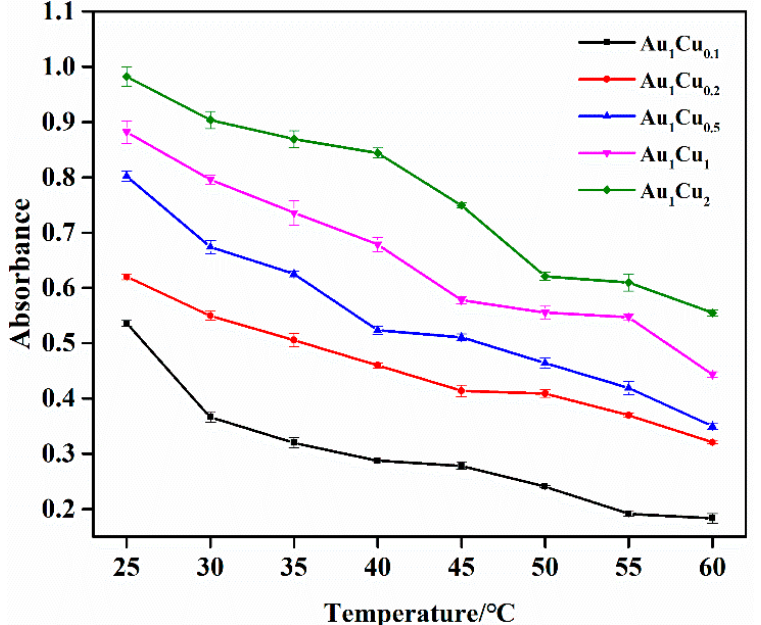
Figure 3. Temperature-dependent response curve for H 2 O 2 detection using the as-prepared Au–Cu alloy nanoparticles at pH = 4. The error bars represent the standard deviation of three measure- ments.